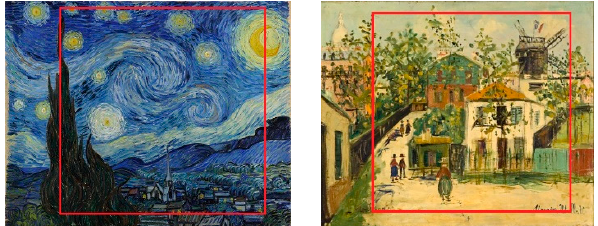
Figure 4. Random crops collected from images.